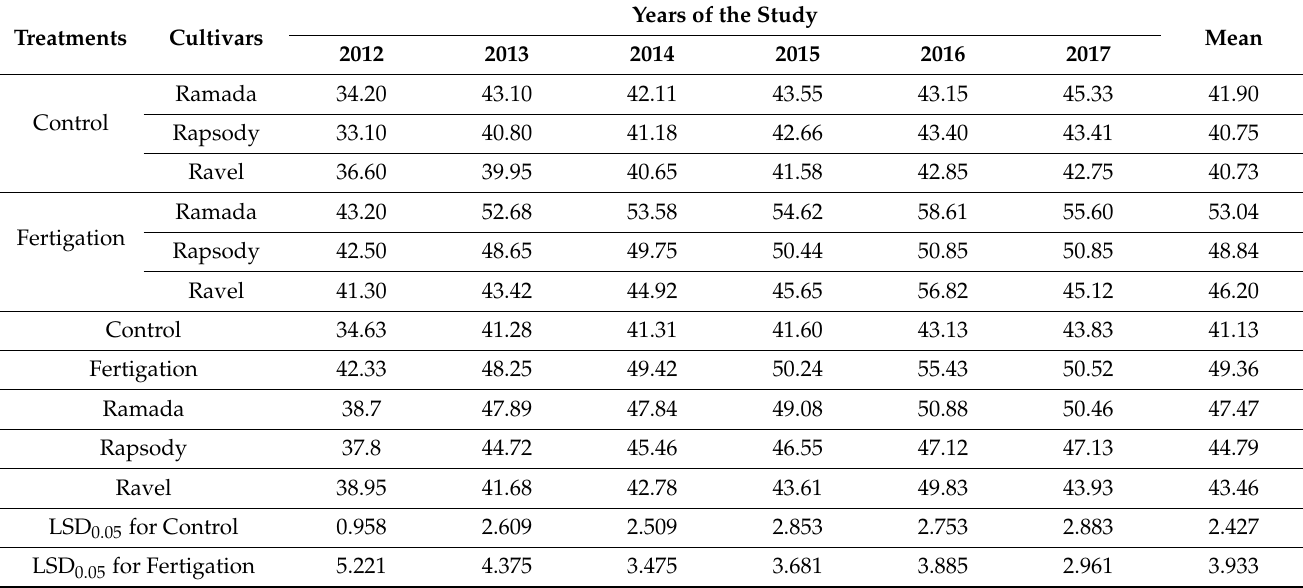
Table 7. The average weight (g) of single green spears of